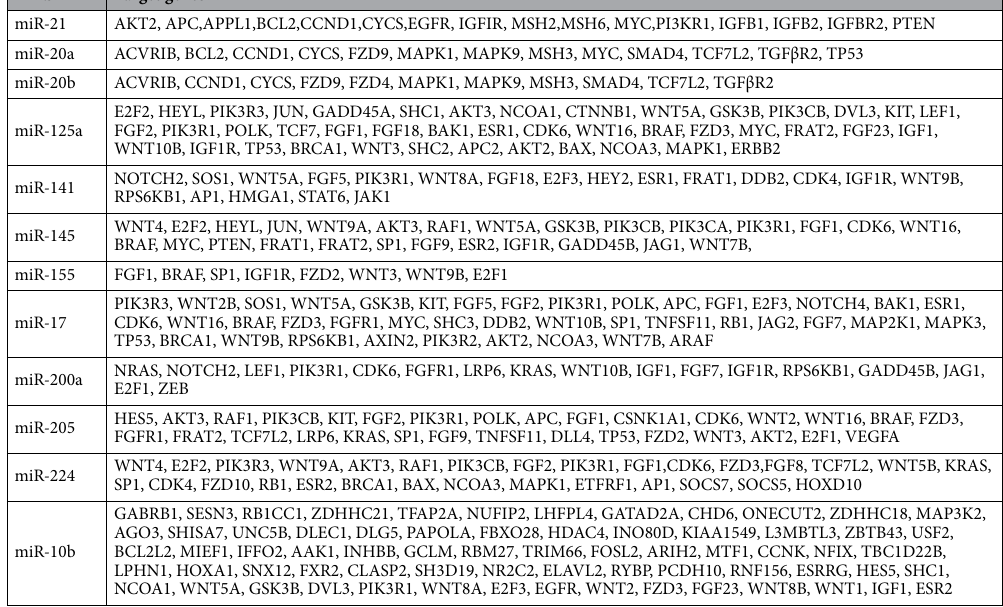
Table 2. Interaction analysis between selected miRs and target genes in breast cancer patients.